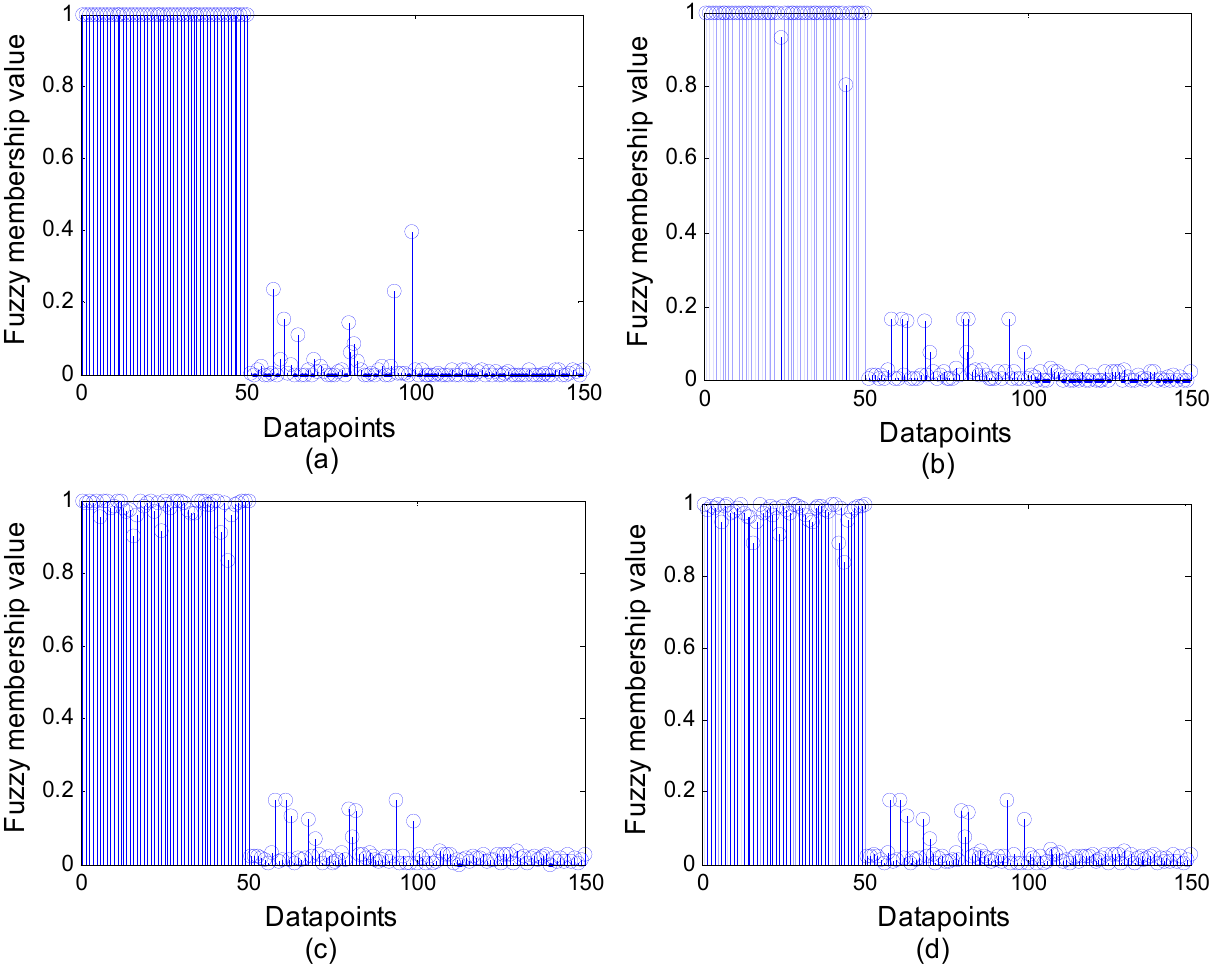
Figure 5. Fuzzy membership value on the first cluster with different  ( a ) =1  ;